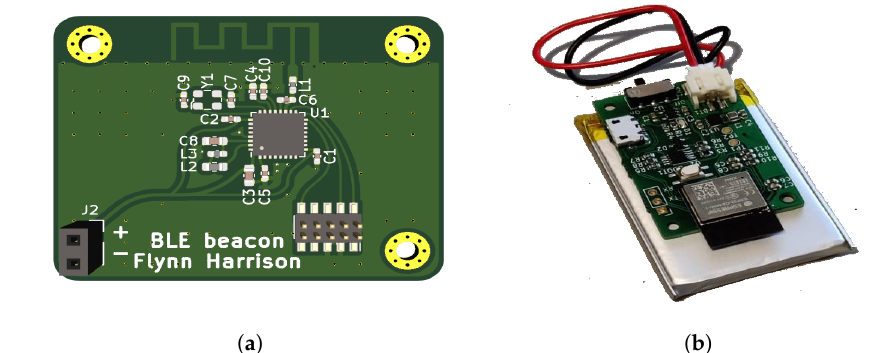
Figure 3. BLE contact tracing IoT system hardware: ( a ) the top side of the BLE beacon, ( b ) the BLE